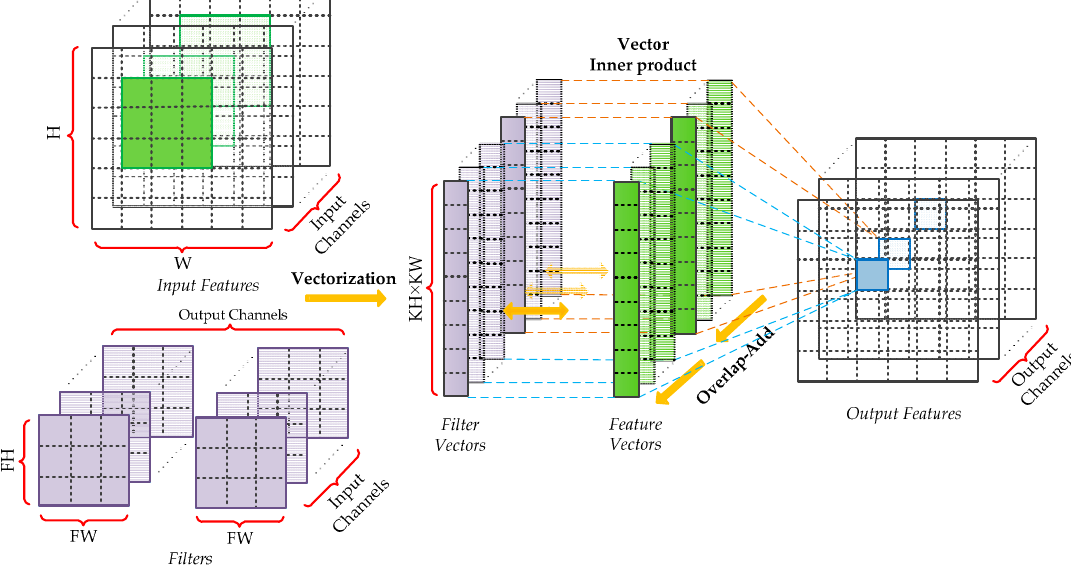
Figure 4. Efficient calculation method for the convolutional and fully connected layers.